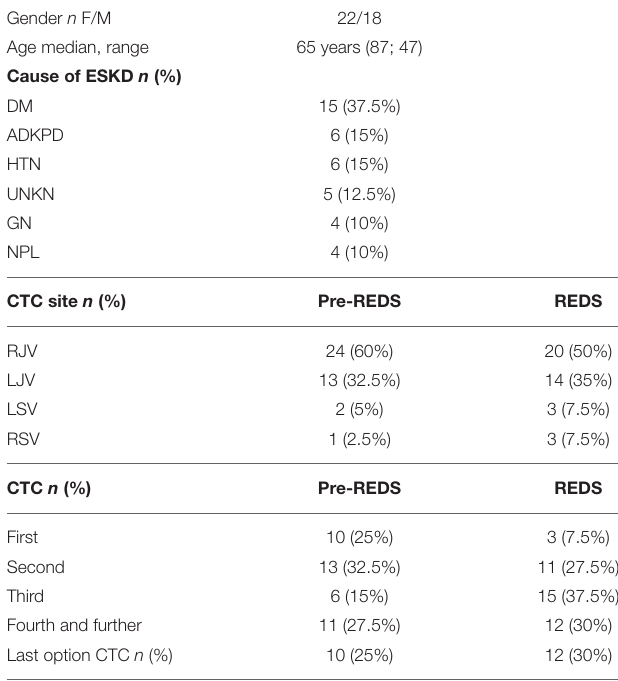
TABLE 1 | Patients’ group